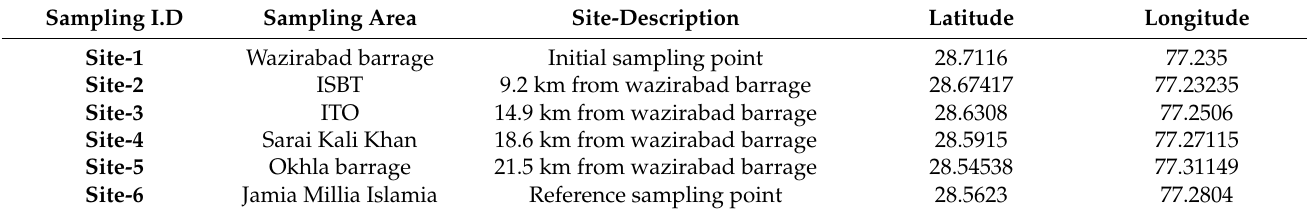
Table 1. Description of the Yamuna River sampling